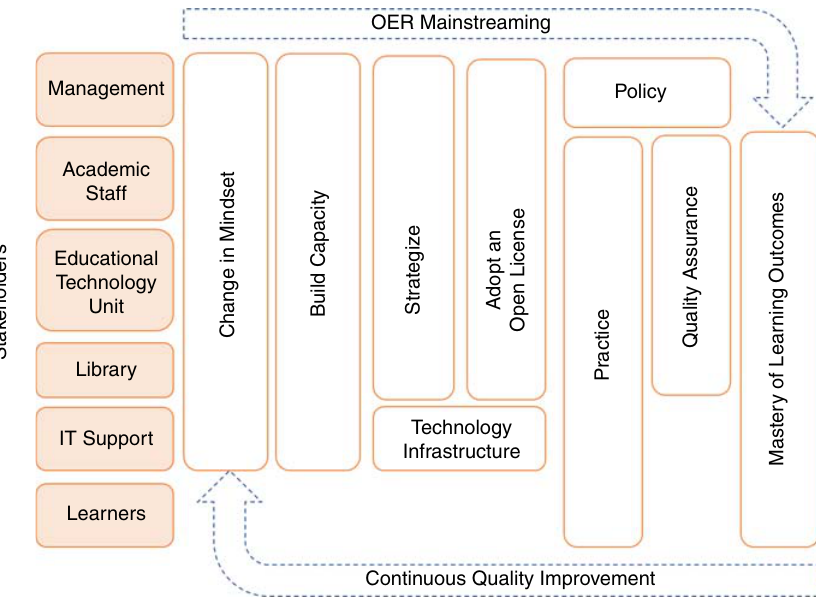
Figure 1. Empirical framework for OER